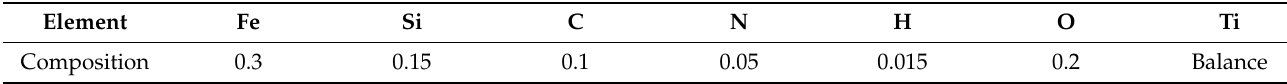
Table 1. Chemical composition of the experimental material